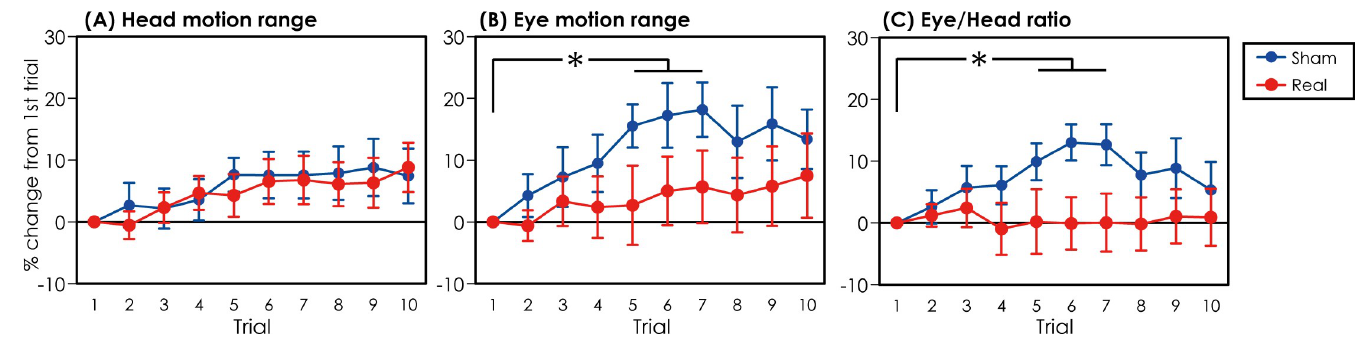
Fig 4. Motion range of the head (A) and eye (B) and the eye/head ratio (C). The blank circles (real rTMS) and solid circles (sham rTMS) indicate mean values. The error bars indicate the standard error.